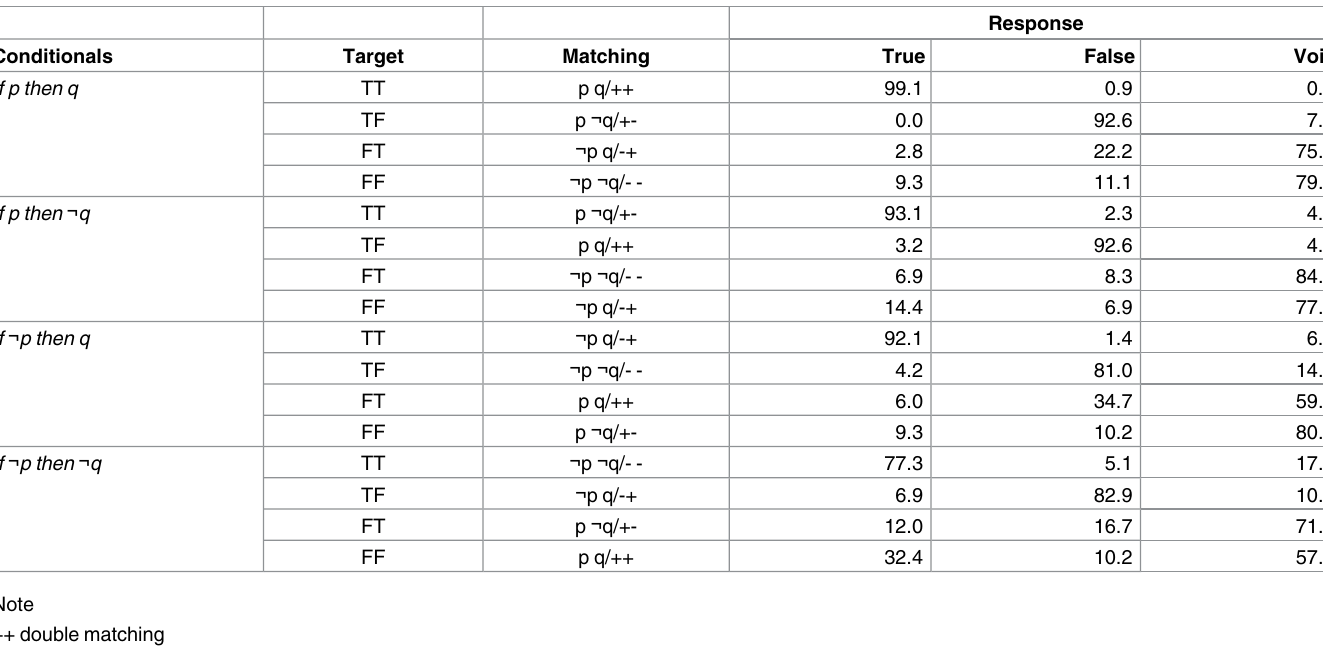
Truth table task. Table 4 shows percentages for the response categories in the truth table task. To test the differences between the response categories for each target in each conditional statement, chi-square and residual analyses were conducted. In all four conditional statements, Table 4. Percentages for the Response Categories (True, False, and Void) in the Truth Table Task in Experiment 2. Response Conditionals